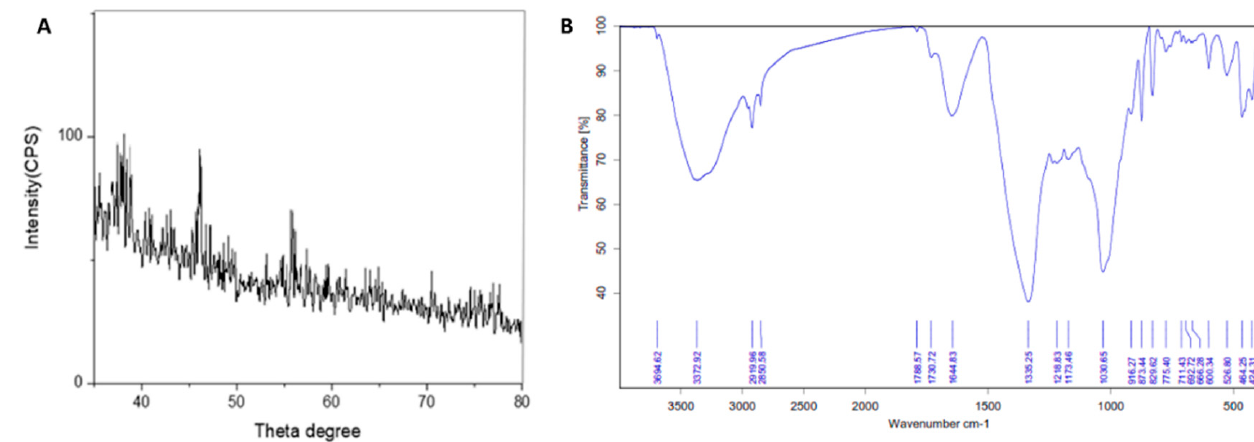
Figure 4. ( A ) X ‐ ray diffraction pattern of the AgNPs; ( B ) FTIR spectra of the prepared AgNPs.